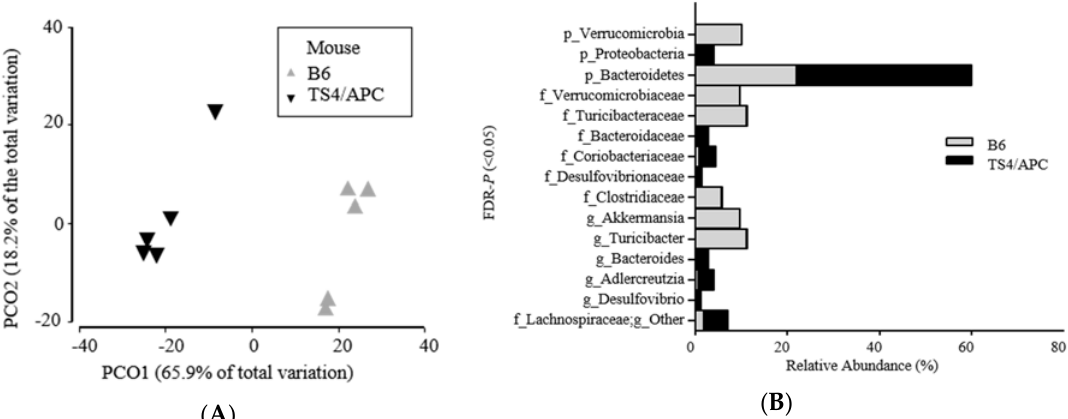
Figure 1 (A ‐ B). Significantly different microbial profiles between TS4/APC (TS4Cre x cAPC l ° x468 mice) chow ‐ fed and B6 (C57BL/6J control mice) chow ‐ fed mice feces: ( A ) Principal coordinate analysis (PCoA) profile of microbial diversity (genus) across all samples, with the percentage of variation explained by PC1 and PC2 indicated in the axis; ( B ) Stacked bars of significantly different (FDR ‐ p ˂ 0.05) rarefied sequences of microbial taxa (relative abundance percentages of total bacteria at phylum, family, and genus) between mice groups.